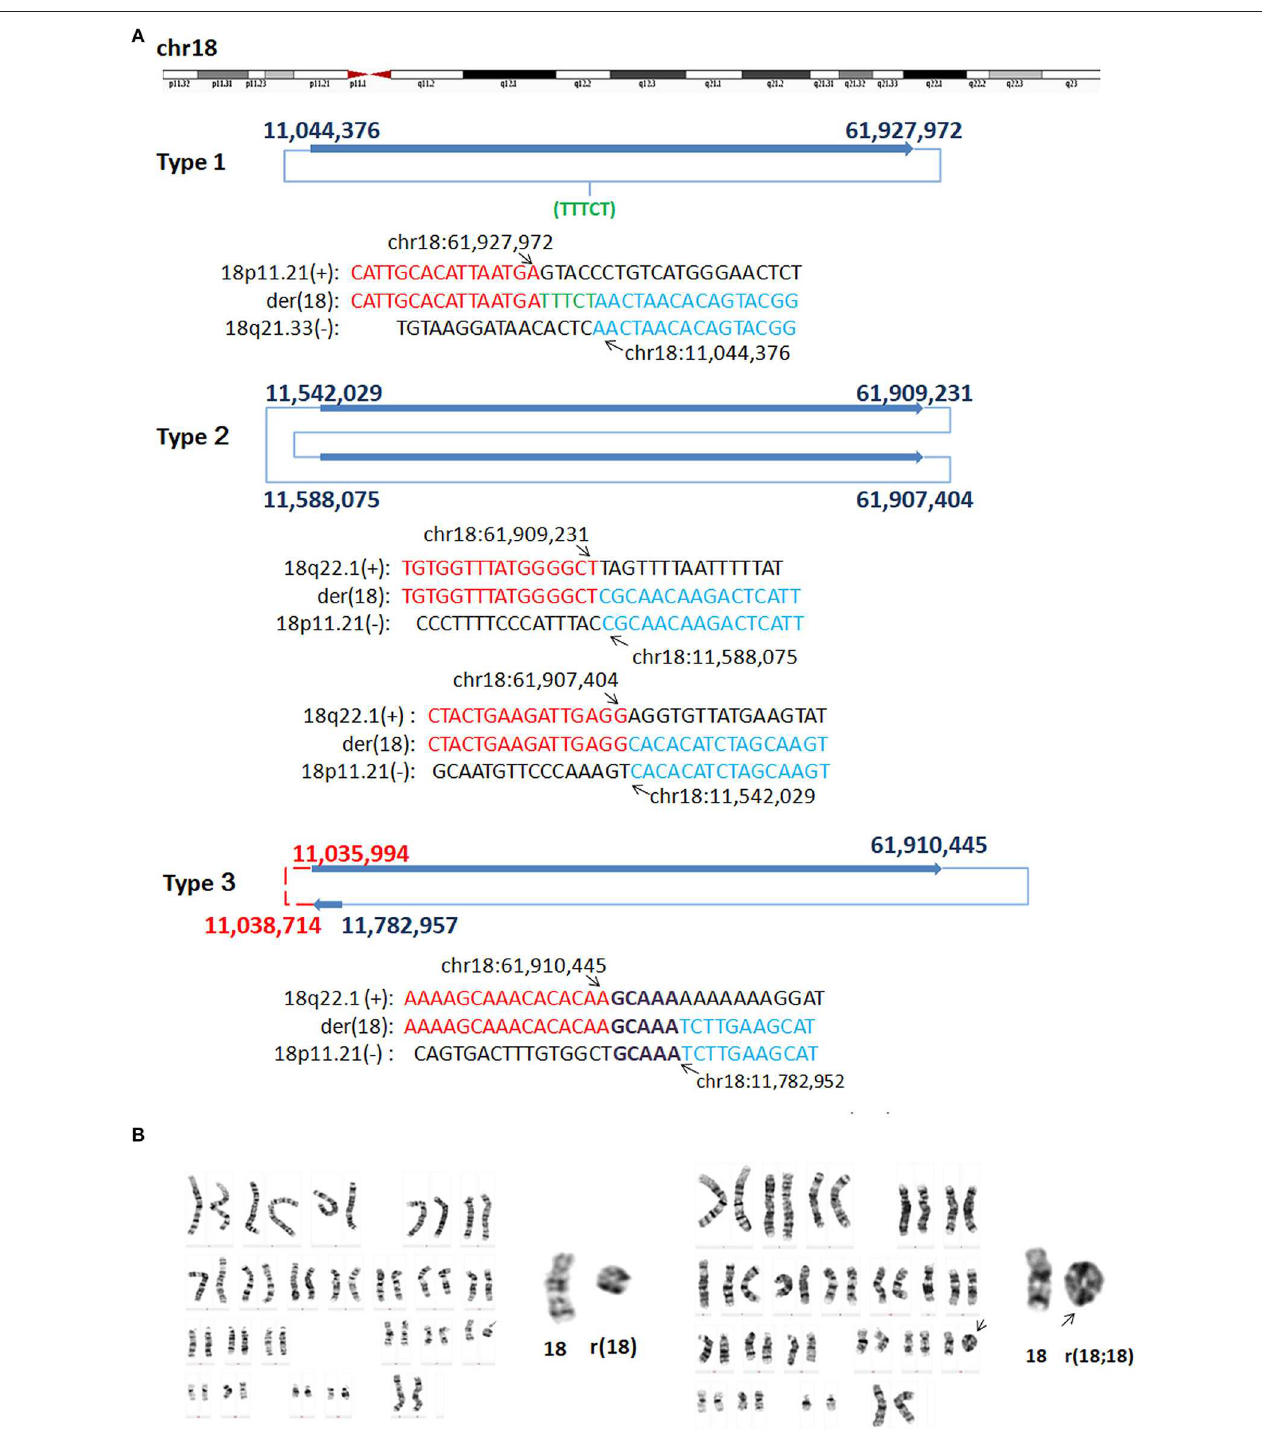
FIGURE 4 | G-band Karyotypes and breakpoints in P8. (A) Breakpoint analysis and validation found three types of rings generated from different breakpoints. Type one: the detailed breakpoint sites were validated to be at 11,044,376 bp (18p11.21) and at 61,927,972 bp (18q22.1), respectively by Sanger sequencing, and an 5 bp insertion was found. Green letter, insertion. Type two: the detailed breakpoint sites were validated to be 11,542,029(18p11.21), 61,909,231(18q22.1), 11,588,075 (18p11.21), and 61,907,404 (18q22.1), respectively. Type three: Two breakpoints were validated to be 61,910,445 bp (18q22.1) and 11,782,957 (18p11.21), the other two breakpoints including 11,035,994 (18p11.21) and 11,038,714 (18p11.21) could not be validated by Sanger sequencing (marked as red). Sequences in bold purple represent microhomology. (B) Karyotyping showed mosaicism on chromosome 18. The ring 18 (left) and ring (18;18) (right) comprised the mosaicism.